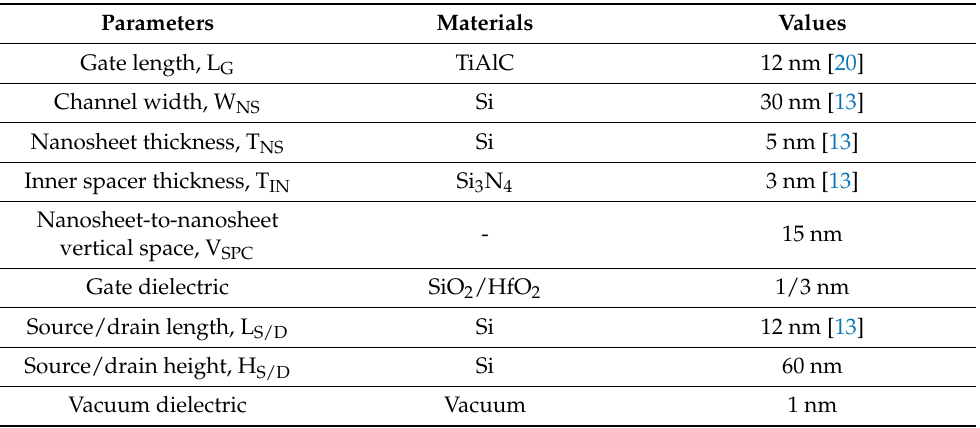
Table 1. Device geometric information for simulations.